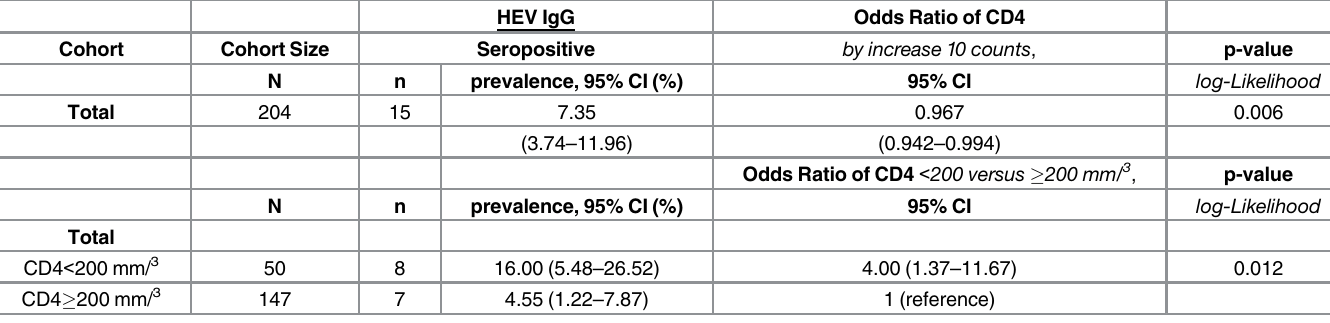
Table 1. HEV seroprevalence according to CD4 count cut